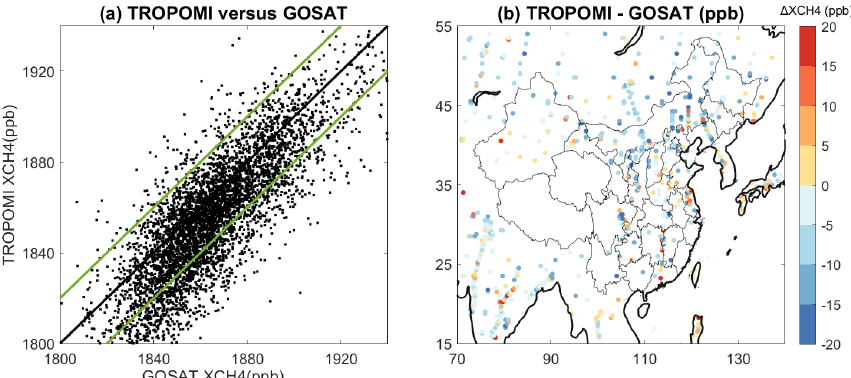
Figure 2. Comparison between 2019 TROPOMI and GOSAT observations of X CH 4 over East Asia. (a) Scatter plot of daily observations on the GEOS-Chem 0 . 25 ◦ × 0 . 3125 ◦ grid. Green lines indicate absolute TROPOMI-GOSAT differences of 20ppb and we exclude the outlying TROPOMI observations. (b) Spatial pattern of annual mean differences (cid:49)X CH 4 between TROPOMI and GOSAT observations after outlying TROPOMI data have been excluded. The mean difference is − 3 . 6 ± 9 . 1ppb. TROPOMI version 2.02 observations are from